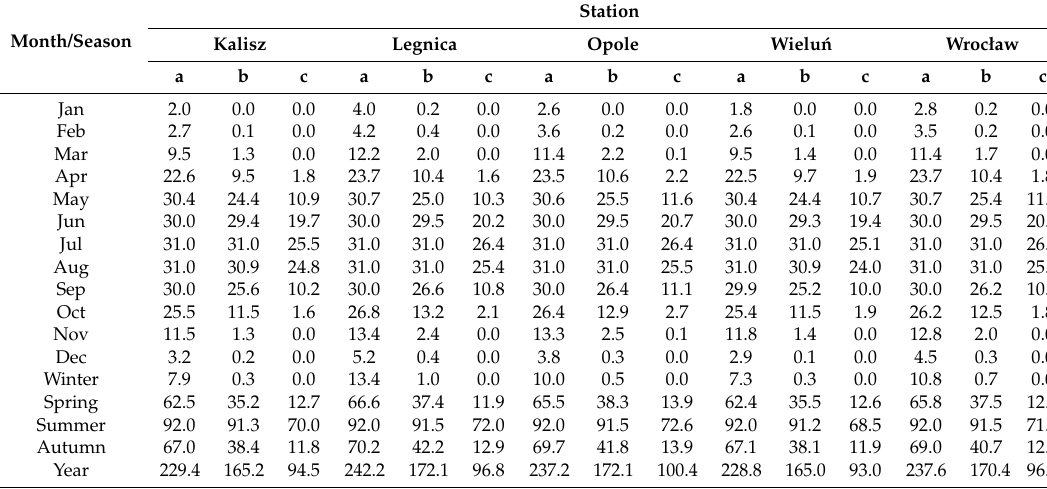
Table 8. Number of days with air temperature (Ta) charaterizing agricultural thermal periods: vegetation (> 5 ◦ C, a), active plant growth (>10 ◦ C, b), and plant maturation (> 15 ◦ C, c) in the analysed stations,